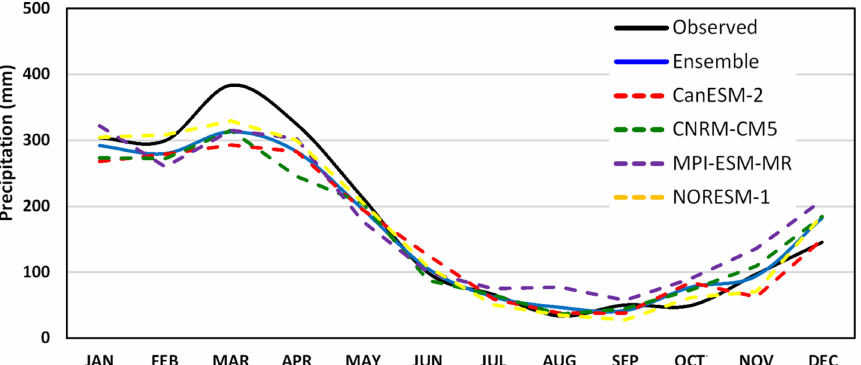
Figure 3. Climatology of monthly precipitation in Altamira for the 1979–2010 period. The different curves correspond to observed data and simulations by the aforementioned models, as well as their